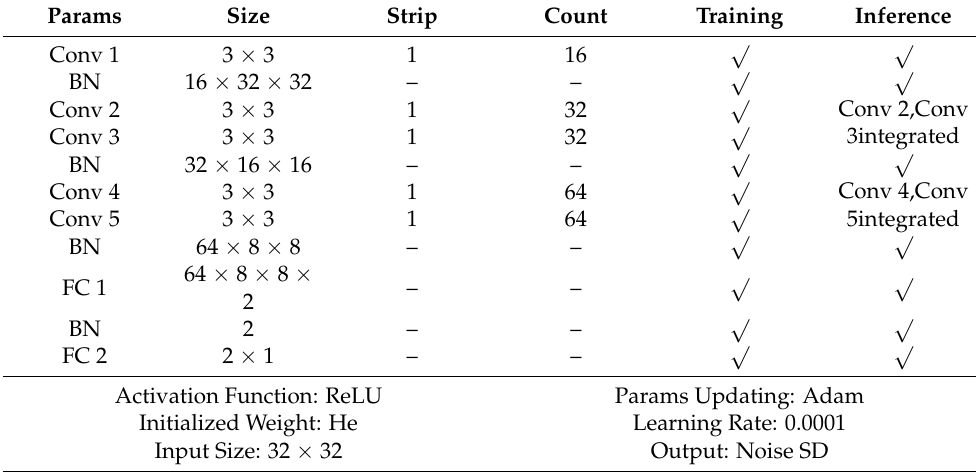
Table 3. The weight parameters of training and